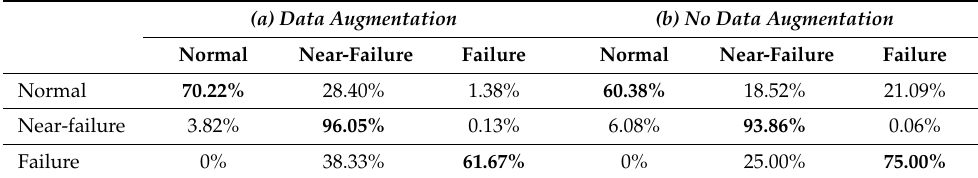
Table 5. Confusion matrices for classifying operational conditions using DNN-R, where we have the following cases (a) with data-augmentation and (b) no data-augmentation.